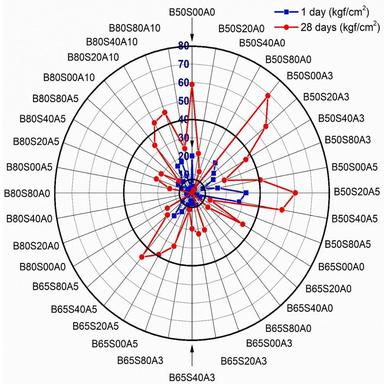
Radar chart of CLSM compressive strength values at 1 and 28 days.